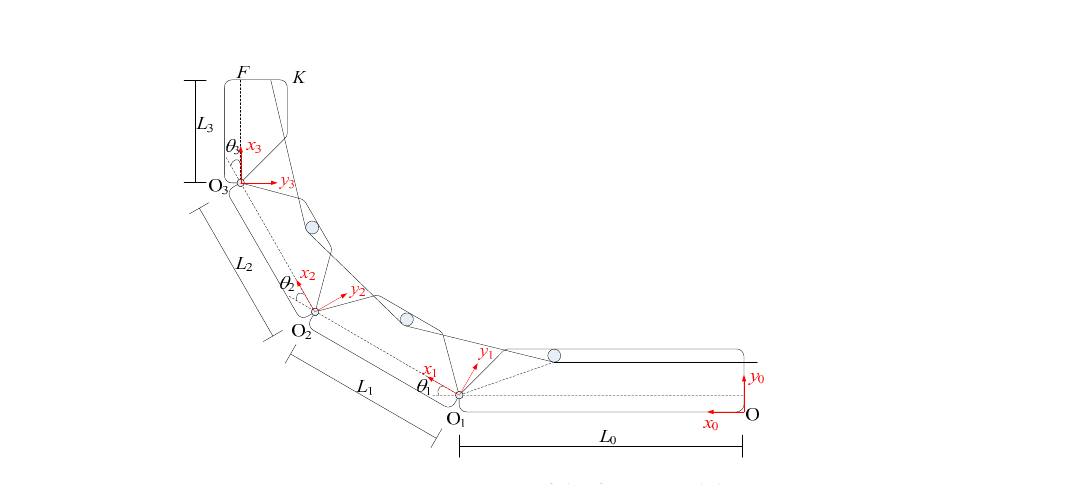
Figure 2. Geometric representation of the finger model. Table 1. Parameters and ranges of the links.